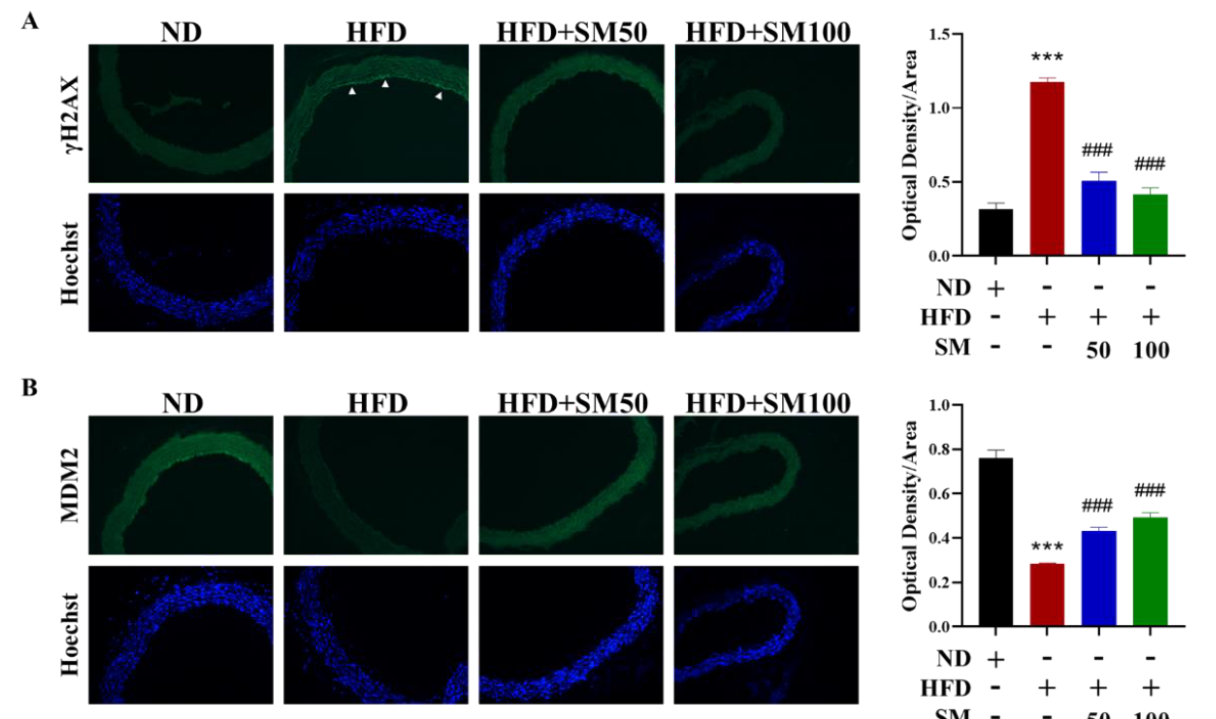
Figure 6. Immunofluorescence staining for γ H2AX and MDM2. Syrian hamsters were fed chow diet (control), HFD, or HFD supplemented with 50 mg/kg SM (HFD + SM50) or 100 mg/kg SM (HFD + SM100) via oral gavage for 18 weeks ( n = 10 per group). ( A ) Cross-sections of thoracic aorta tissues from treated mice were stained for γ H2AX, a reliable marker of DNA double-strand breaks, using immunofluorescence. The endothelium was stained with positive staining as indicated by arrows. ( B ) Immunofluorescence staining of MDM2. Hoechst 33342 was used as a nuclear marker. Quantification of the percentage of cells with the presence of H2AX or MDM2. *** p < 0.001 vs. ND group; ### p < 0.001 vs. HFD group.